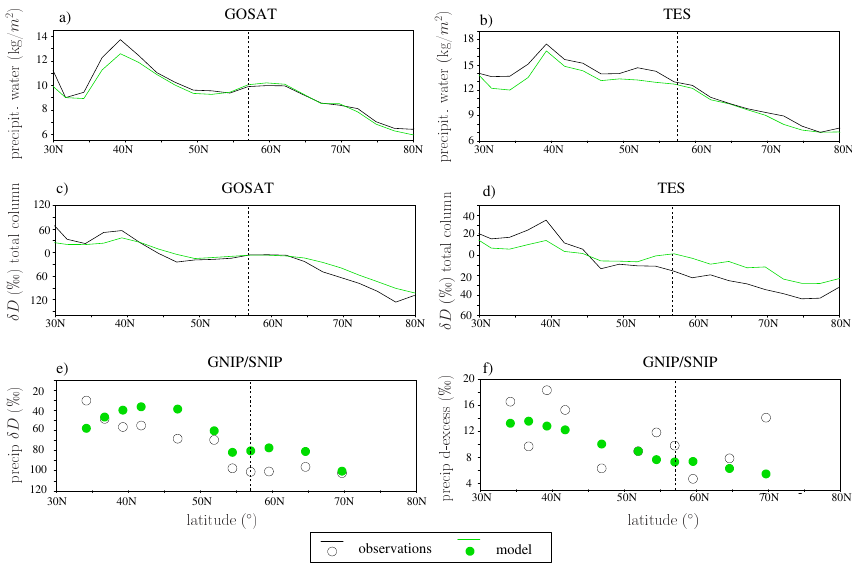
Fig. 4. Annual mean north-south transects of observed (black) and simulated (green) precipitable water Figure 4. Annual mean north–south transects of observed (black) and simulated (green) precipitable water observed by GOSAT (a) and by observed by GOSAT (a) and by TES (b), δD in the total column water vapor as observed by GOSAT (c) TES (b) , δD in the total column water vapor as observed by GOSAT (c) and by TES (d) , δD in the surface precipitation (e) and d excess and byTES(d), δD in thesurface precipitation(e) andd-excessin the surfaceprecipitation(f). Transects in the surface precipitation (f) . Transects are taken around the longitude of Kourovka: 50–70 ◦ E. For satellite data sets, the annual-mean δD are taken around the longitude of Kourovka: 50 ◦ E-70 ◦ E. For satellite datasets, the annual-mean δD averaged over 50–70 ◦ E–30–80 ◦ N is subtracted to focus on the latitudinal variations. LMDZ outputs are collocated with each data set and averaged over50 ◦ E-70 ◦ E-30 ◦ N-80 ◦ N is subtracted to focuson the latitudinal variations. LMDZ outputs are collocatedwith each datasetand averagingkernelsare applied to comparewith satellite datasets. The averaging kernels are applied to compare with satellite data sets. The dashed line indicates the latitude of dashed line indicates the latitude of Kourovka.